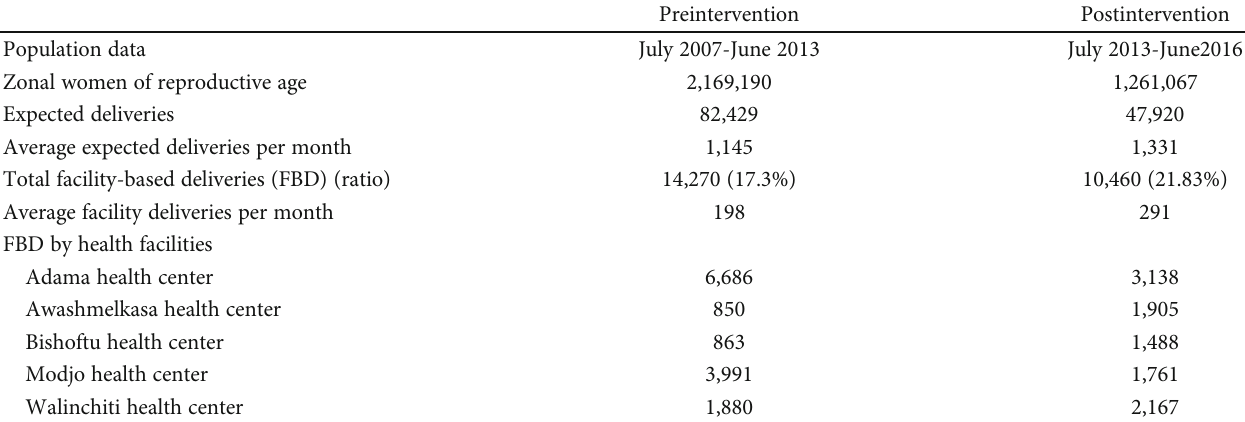
Table 1: The population of women of reproductive age and service data before and after the free delivery care policy implementation.